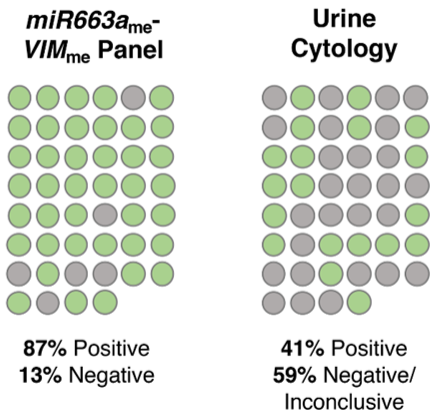
Figure 3. ( A ) Distribution of VIM me and miR663a me levels in the Validation Cohort #1, composed by healthy donors (HD; n = 57) and bladder carcinoma (BlCa; n = 100) urine samples. Mann-Whitney U (MW) test, **** p < 0.0001. Median is represented by the red line. ( B ) Receiver operator characteristic (ROC) curve evaluating the performance of the VIM me - miR663a me panel for the identification of BlCa in urine samples of the Validation Cohort #1. ( C ) Distribution of VIM me and miR663a me levels in the Validation Cohort #2, composed by inflammatory controls (IC; n = 174) and bladder carcinoma (BlCa; n = 100) urine samples. MW test, **** p < 0.0001. ( D ) ROC curve evaluating the performance of the VIM me - miR663a me panel for the identification of BlCa in urine samples of the Validation Cohort #2. (AUC—Area under the curve; CI—Confidence interval; ACTB—Beta-Actin; VIM—Vimentin).